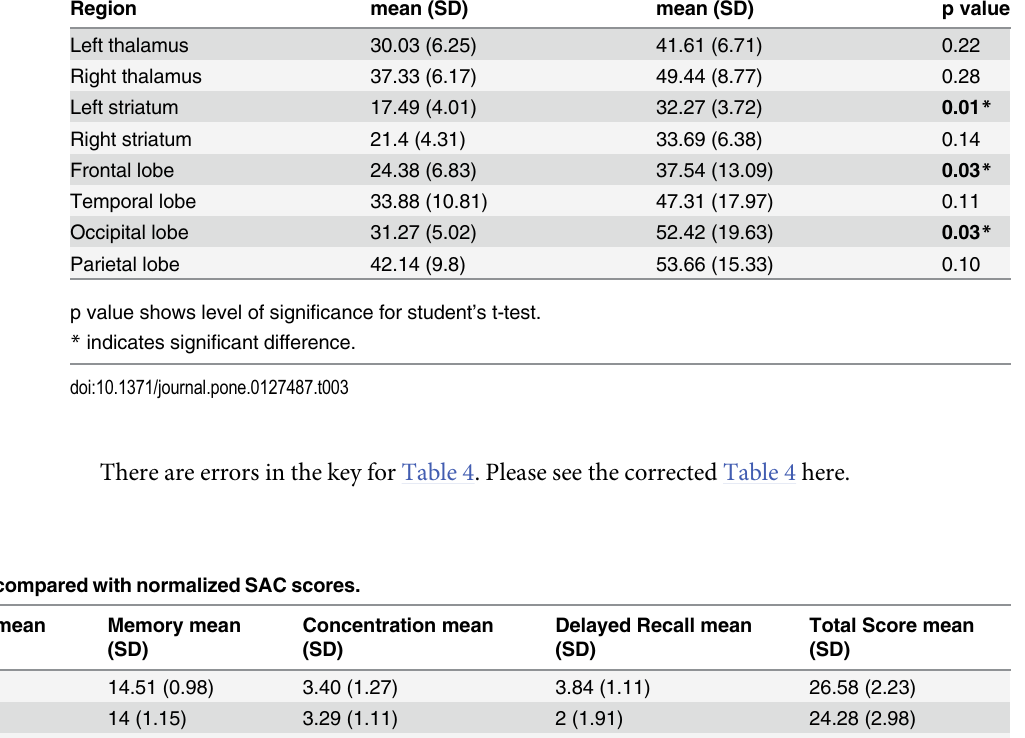
There are errors in the key for Table 3. Please see the corrected Table 3 here.